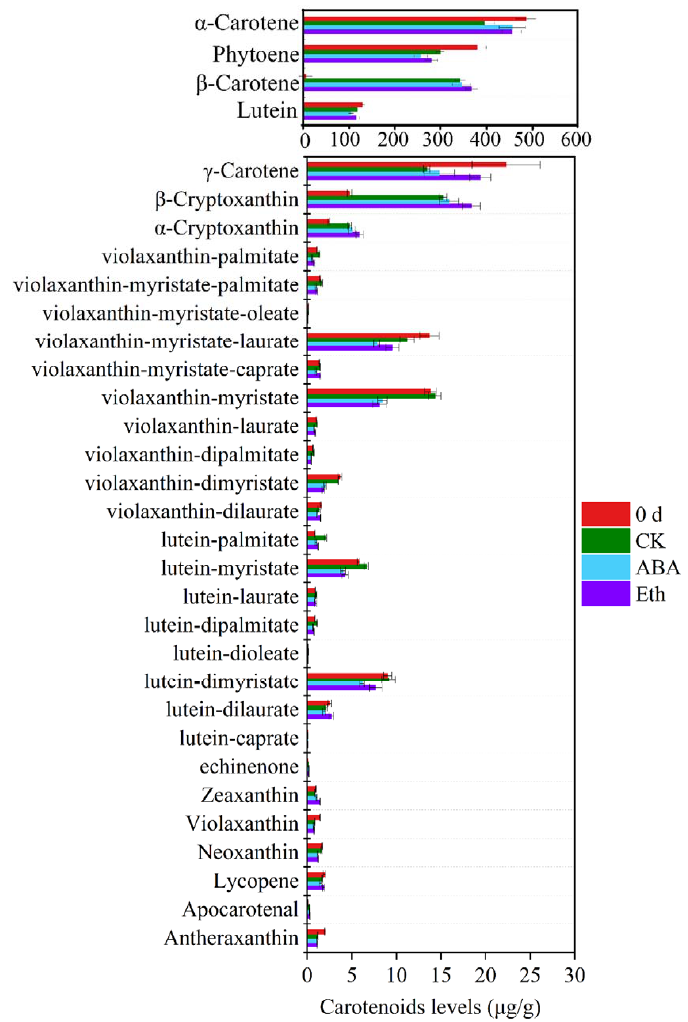
Figure 2. Metabolome analysis of effects of ABA and Eth on carotenoids.